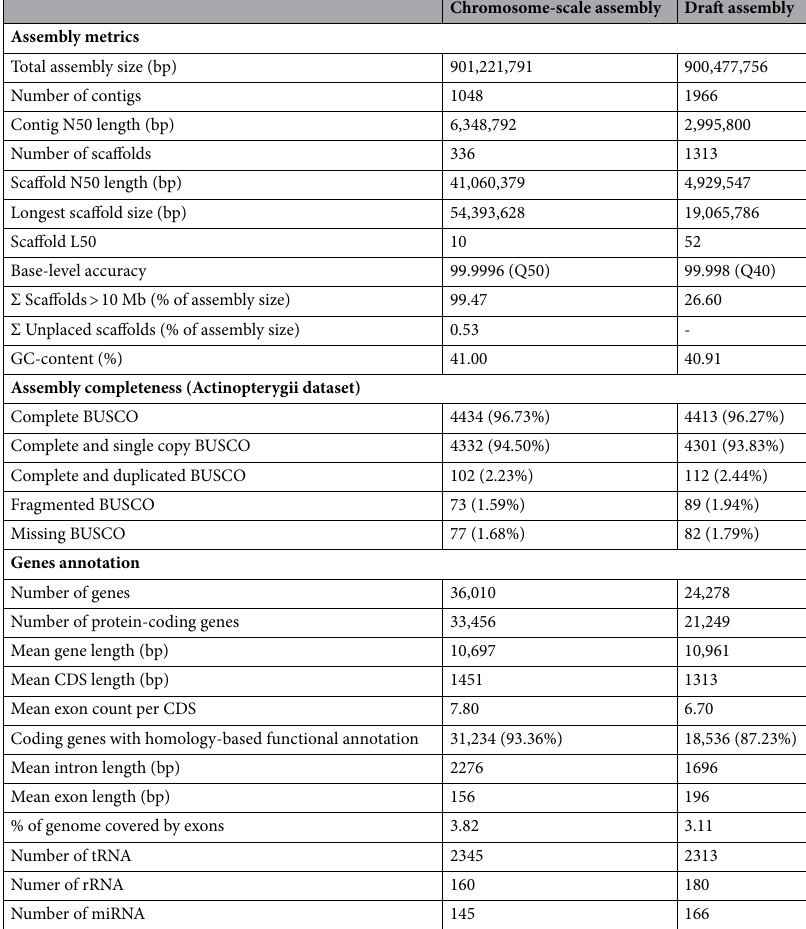
Table 3. Comparison of statistics between our chromosome-scale assembly and the first published pikeperch draft assembly (GenBank accession PRJNA561467). Genome annotation metrics were taken from Nguinkal et al. (2019) 21 . Differences between the statistic results shown in this table and NCBI are due to the use of different genome annotation